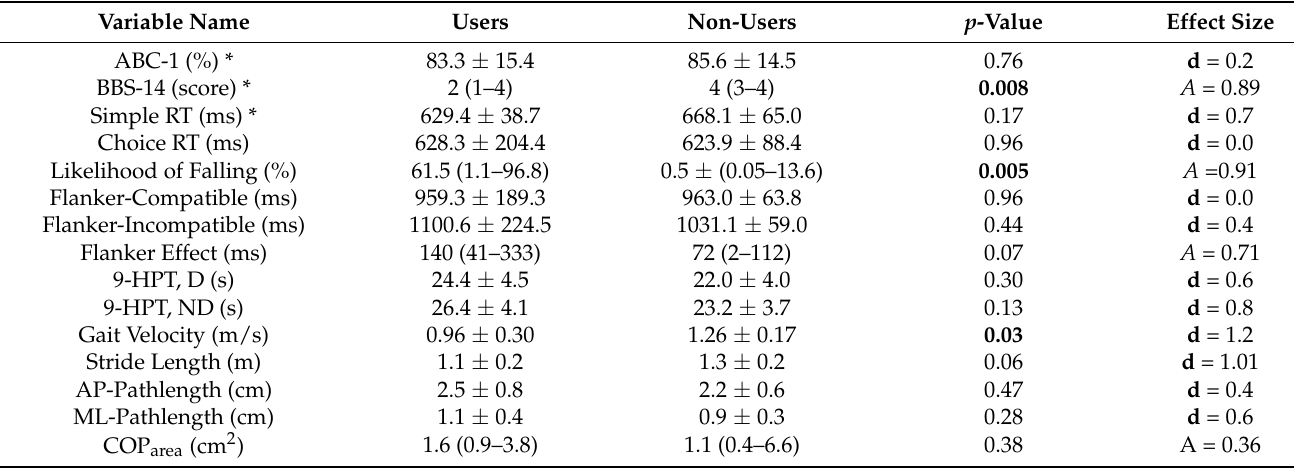
Table 2. Central tendency, variability, significance, and effect size ( d or A ) for all variables compared between cannabis Users and Non-Users. Data are mean ± SD or median (range). Significant p -values are in